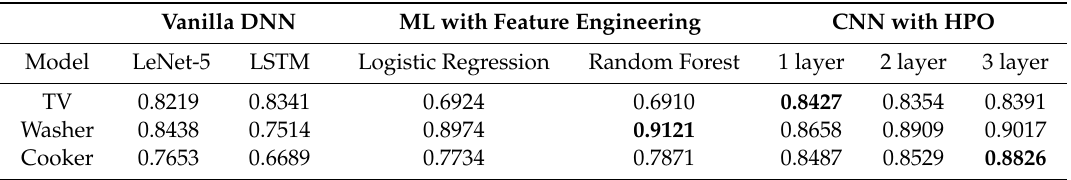
Table 6. Summary of classification performance (area under receiver operating characteristic curve (AUROC) values).